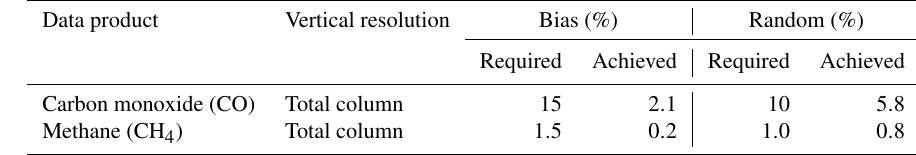
Table 4. Achieved product quality compared to the mission requirements extracted from ESA (2017).